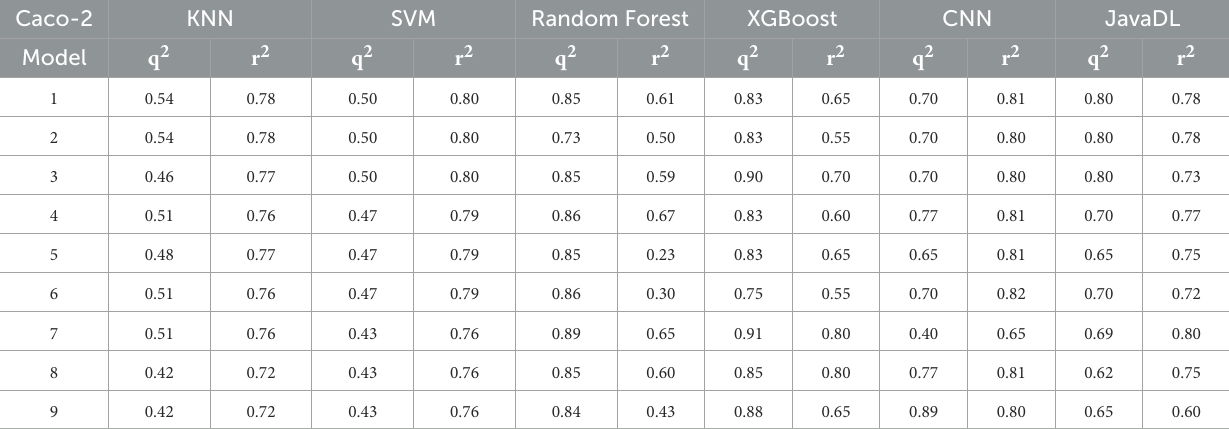
TABLE 1 Method comparison with the Caco-2 dataset.